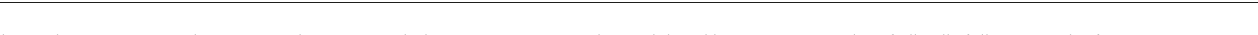
Fig. 6 Changes in open chromatin architecture underlie DTP transition and are inhibited by JQ1. a t-SNE plot of all cells following 72 h of 1 μ M BEZ235, 1 μ M Trametinib, or a DMSO control in HCC1143, calculated from sciATAC-seq results. Single cells are colored based on treatment, BEZ235 (magenta), Trametinib (cyan), DMSO (gray). b A dot plot showing enriched DNA-binding protein motifs in the open chromatin sites following BEZ235 or Trametinib treatment, normalized to DMSO values. Select related transcription factor motifs are enlarged, colored, and labeled. c t-SNE plot of all cells following 72 h of 1 μ M JQ1 (yellow), 1 μ M BEZ235 (magenta), JQ1 + BEZ235 (maroon), or a DMSO control (gray), calculated as in ( a ). d Line graph showing the level of motif-enrichment for six groups of transcription factors is shown for DMSO, BEZ235, JQ1, and JQ1 + BEZ235 treatments. e Graph of GSEA results showing transcription-factor activity-related genesets shown to be signi fi cantly enriched ( P < 0.05) following 72 h of BEZ235 treatment. The NES in JQ1-treated, and BEZ235 + JQ1-treated cells shown adjacently. f IF images showing K18, K14, and GATA3 expression in HCC1143 cells following 72 h treatment, scale bars = 100 μ m. g Graph showing the frequency of GATA3 + cells in HCC1143 following treatment, asterisks depict signi fi cant differences in GATA3 + frequency, * P < 0.05, ** P < 0.01, **** P < 0.001, n = 3 with SEM. h Graph of GSEA results showing the NES of breast phenotype genesets shown to be signi fi cantly enriched ( P < 0.05) following 72 h of BEZ235 treatment, with the subsequent NES of that geneset in JQ1-treated, and BEZ235 + JQ1-treated cells shown adjacently. i A graph showing change in tumor volume in HCC70 xenografts treated with vehicle control (black), BEZ235 (red), JQ1 (blue), or BEZ235 + JQ1 (purple). Asterisks denote signi fi cant difference in tumor volume between combination-treated tumors and other groups, denoted by color, n = 8 with SEM. j Graph showing the frequency of K14 + human (KU80 + ) tumor cells in each HCC70 xenograft following treatment with BEZ235, JQ1,